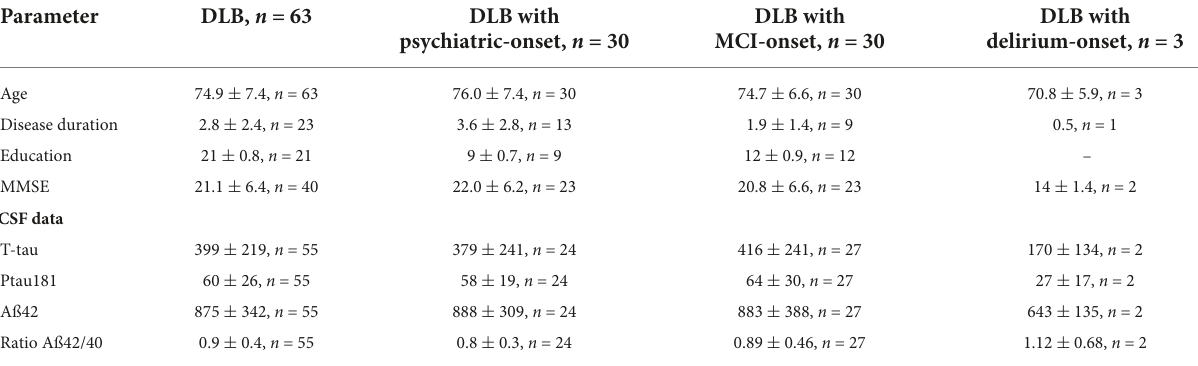
TABLE 1 Demographic and clinical data of